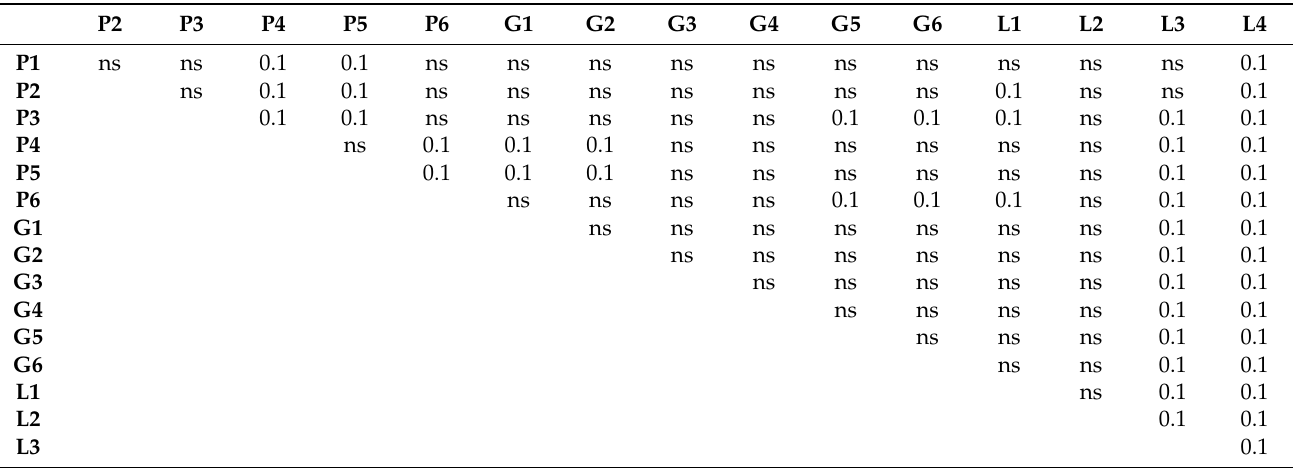
Table A4. ARG composition differences between locations by pair-wise analysis, p = 0.1 was seen as different while p > 0.1 (as ns in the table) was not. P, pasture; G, greenhouse; L, lake.